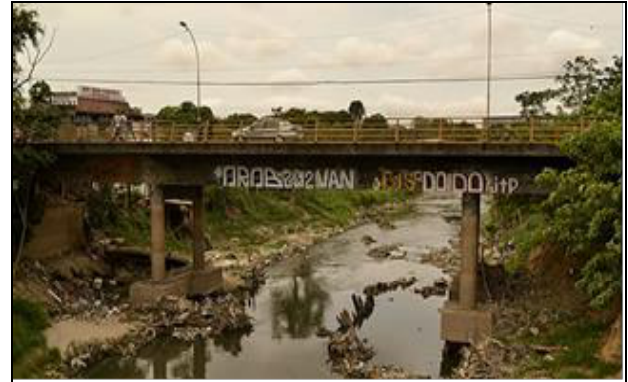
Figura 7 :Igarapé do quarenta na ponte do bairro raiz. Fonte: Autores, (2018).